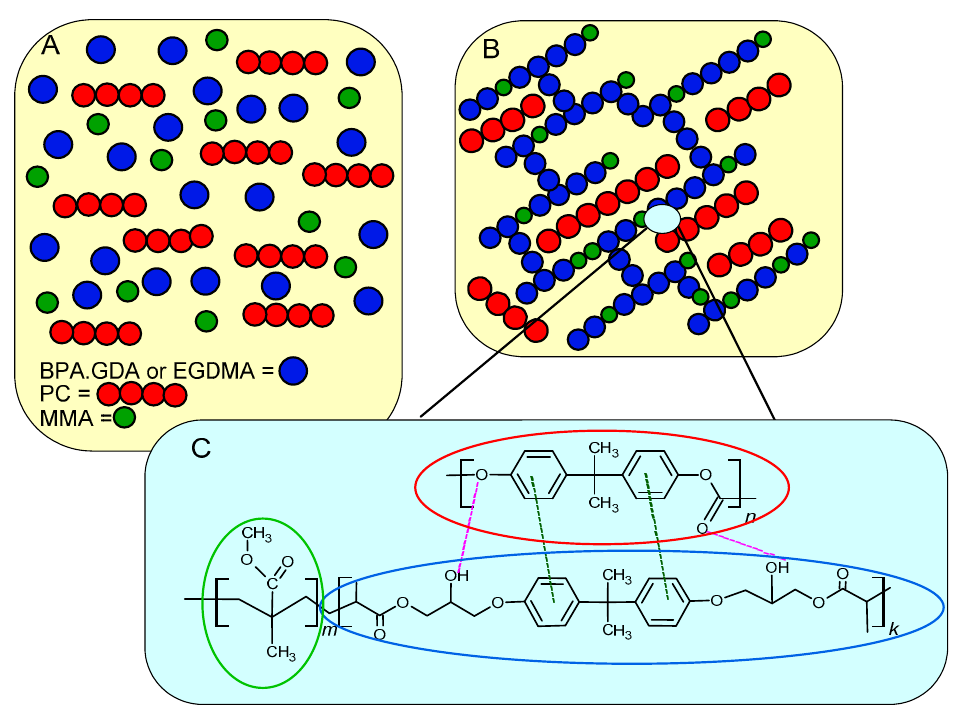
Figure 2. Proposed scheme of polymeric blends structure—before ( A ) and after ( B ) the polymerization reaction with potential interactions between the functional groups ( C ).